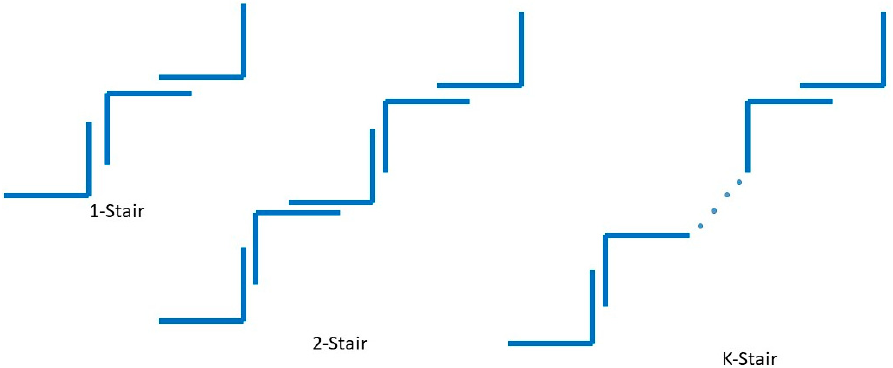
Figure 8. Stair Edge Tiling.